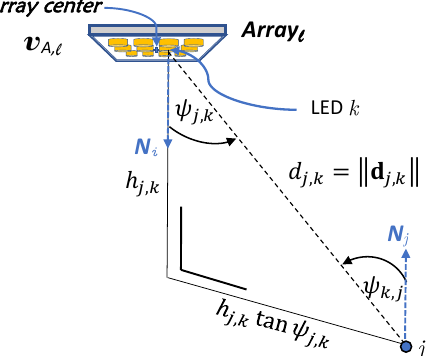
Figure 1. Geometrical definitions in the illumination system, k corresponds to the pair ( (cid:96) , i )